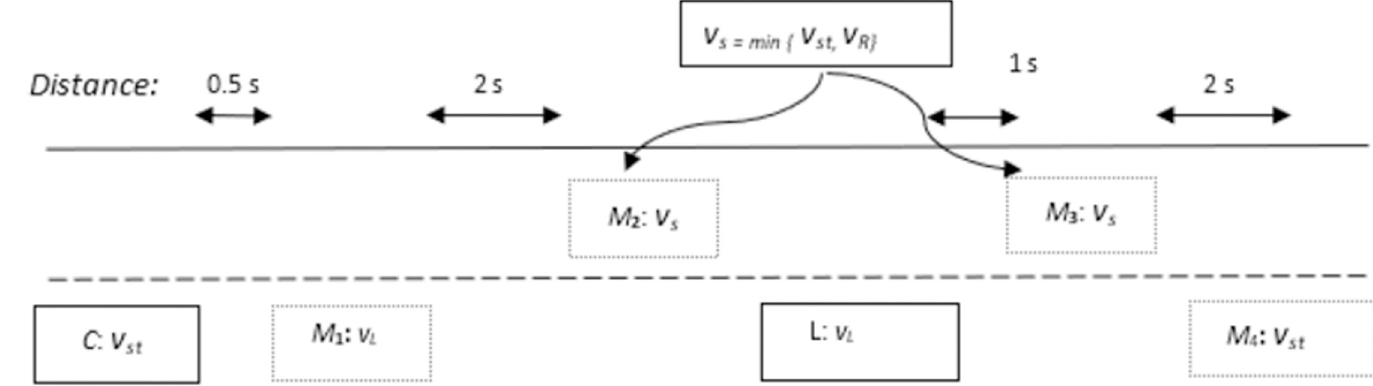
Fig 5. Position of marker targets for scenario